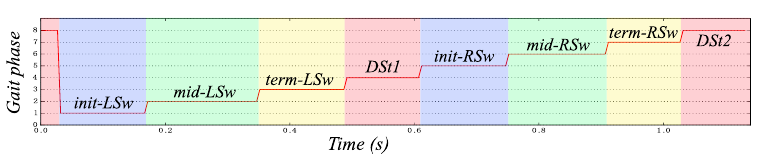
Figure 6. Gait phase classification process of one gait cycle from EGC, where: LNC, left no contact; LFC, left floor contact; RNC, right no contact; RFC, right floor